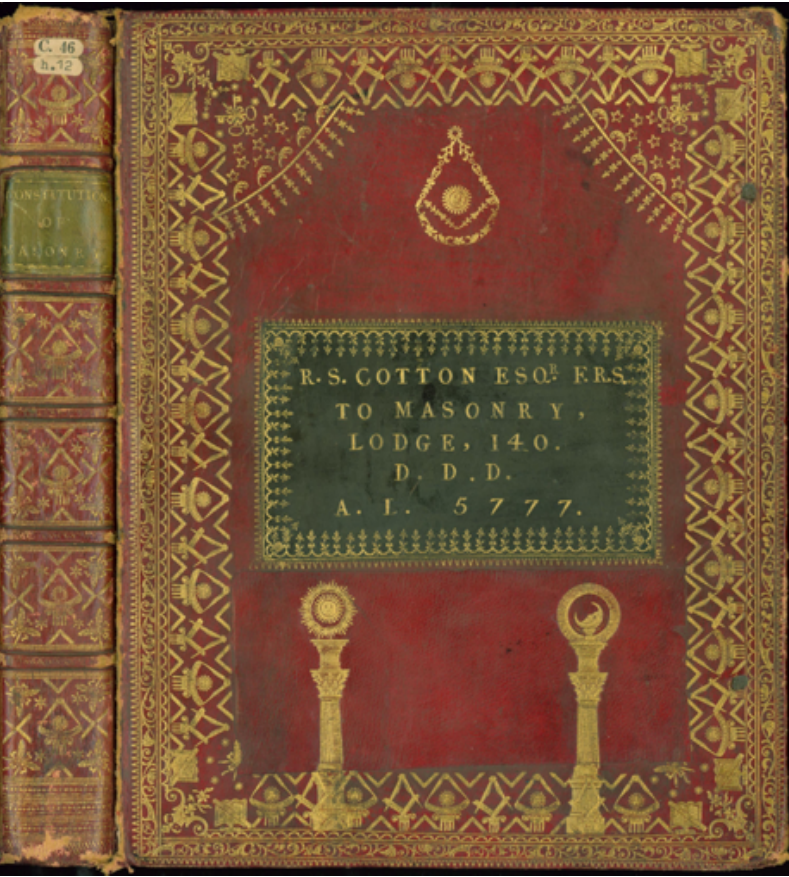
Fig. 30. The Constitutions of the ... Masons (London, 1767-1776). Upper cover and spine. Note the raised spine bands. This choice of this particular sewing structure was likely due to the large format of the text. BL, C.46.h.12.